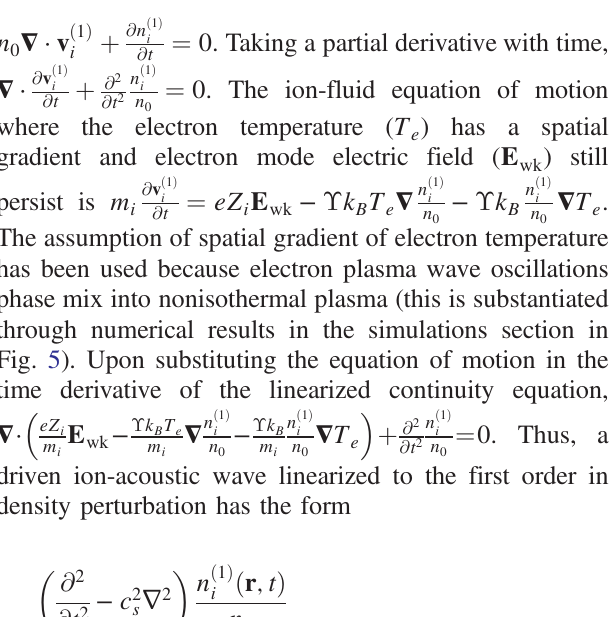
FIG. 3. Bubble-wake train behind an ultrarelativistic electron ≪ β ≃ β beam with bubble: β . (a) Electron density in 2D ϕ g beam cylindrical real space, (b) corresponding longitudinal electric field profile and (c) corresponding radial-field profile. Here the beam is located between 170 and 180 c . The bubbles just behind ω pe the driver in (a) undergo phase mixing over several cycles. The intermediate stages of the extent of phase mixing can be inferred from the bubbles that are closer to the beam. The beam-plasma parameters are the same as in Fig. 2 but the electron wake is shown at an earlier time t ¼ 150 ω − 1 pe